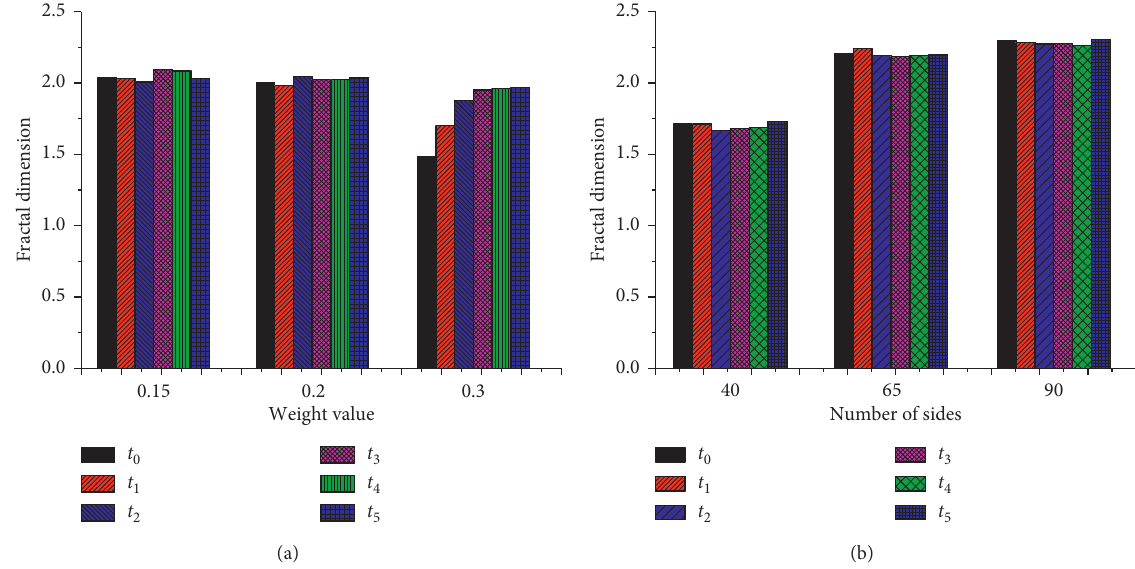
Figure 10: The calculation results of the fractal dimension in the binary network based on (a) M 1 and (b) M